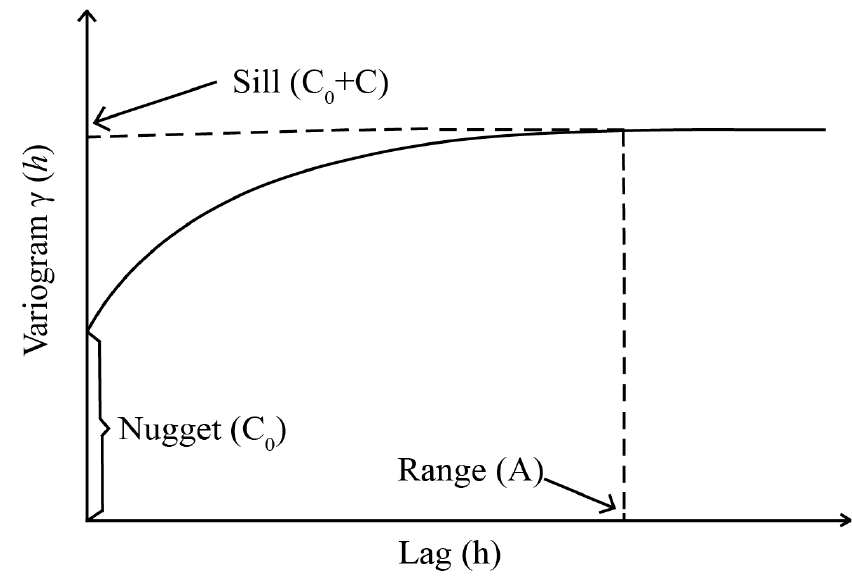
Figure 2. The variogram model illustrating nugget, sill, and range. As these estimates may fluctuate substantially from point to point due to sampling errors, models describing spatial variation must be fitted. We tested multiple models, including exponential, spherical, linear, and Gaussian models, using the following criteria to select the optimal one: an intercept ( β 1 ) near zero, a slope ( β 0 ) near 1, a large regression coefficient, a mean error close to zero, and a low root mean square error. Nugget effects, ranges, sill, and coefficients of determination were calculated for each model